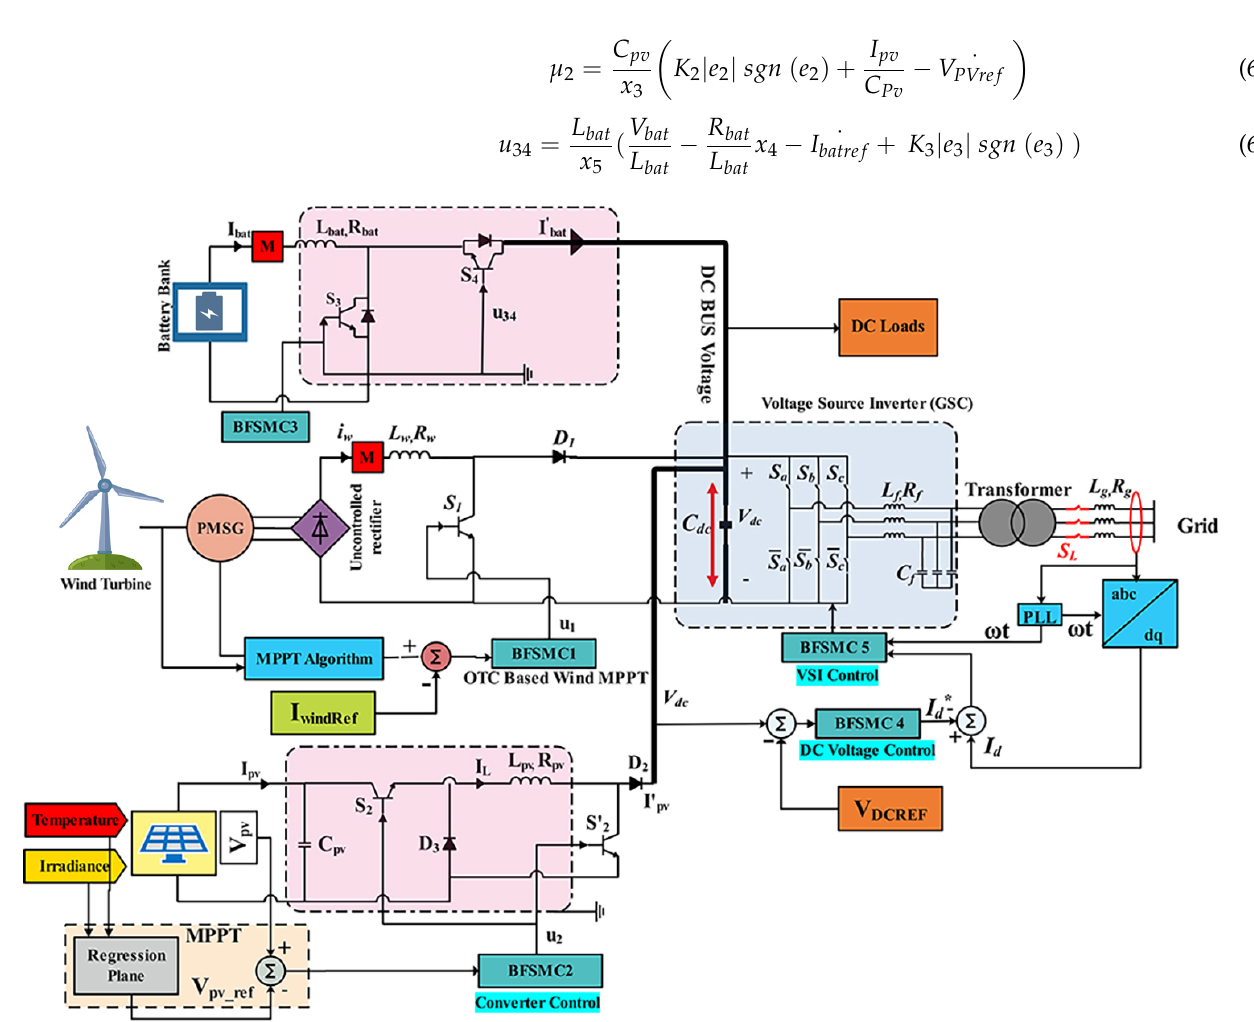
Figure 6. AC/DC configuration of proposed